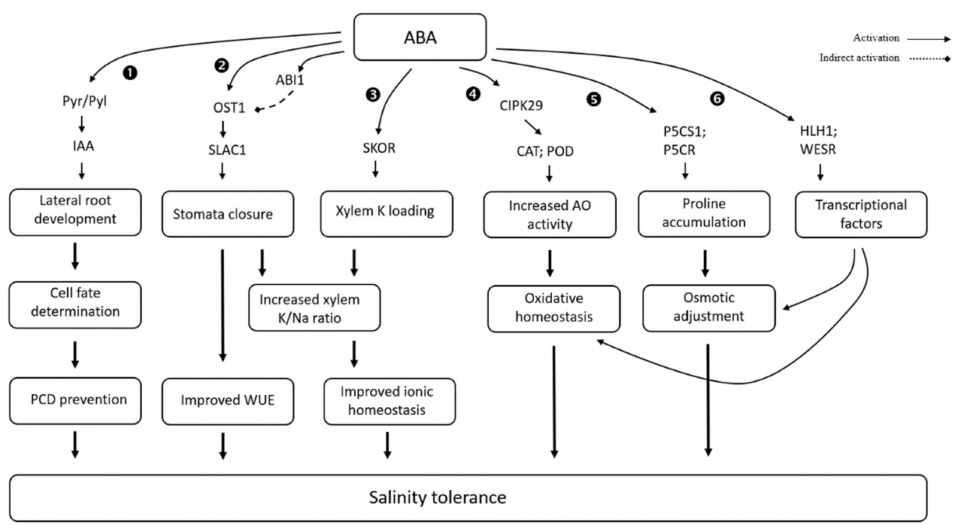
Figure 3. Effect of abscisic acid on salt stress tolerance in plants (based on (cid:182) [240], (cid:183) [223], (cid:184) [241], (cid:185) [236], (cid:186) [231], and (cid:187)